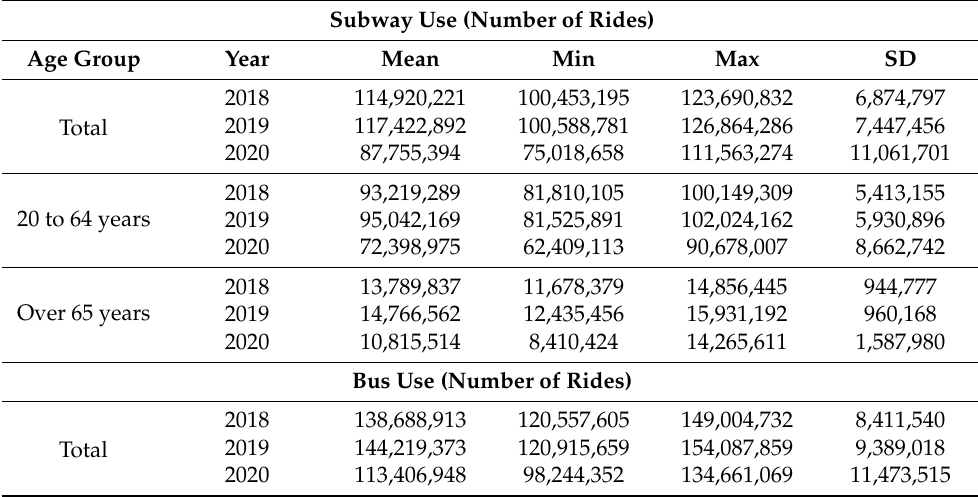
Table A1. Statistics on mass transit use in Seoul during 2018 to